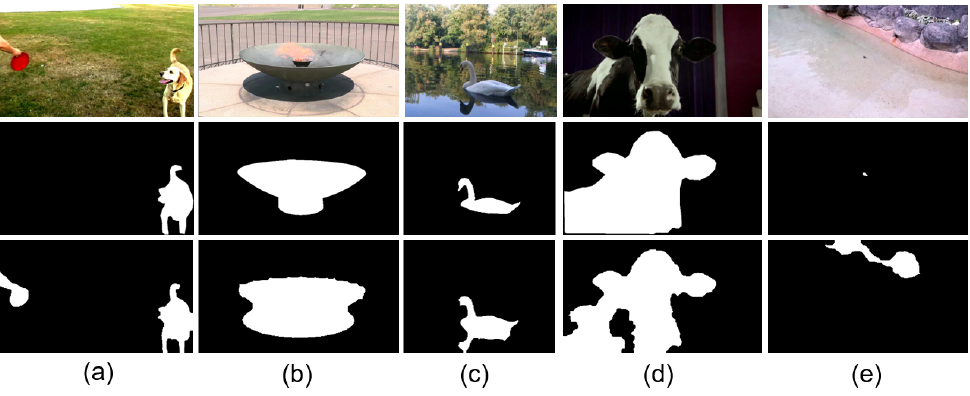
Figure 8. Failure cases of our approach. Rows from top to bottom: video frames, ground-truth masks and our